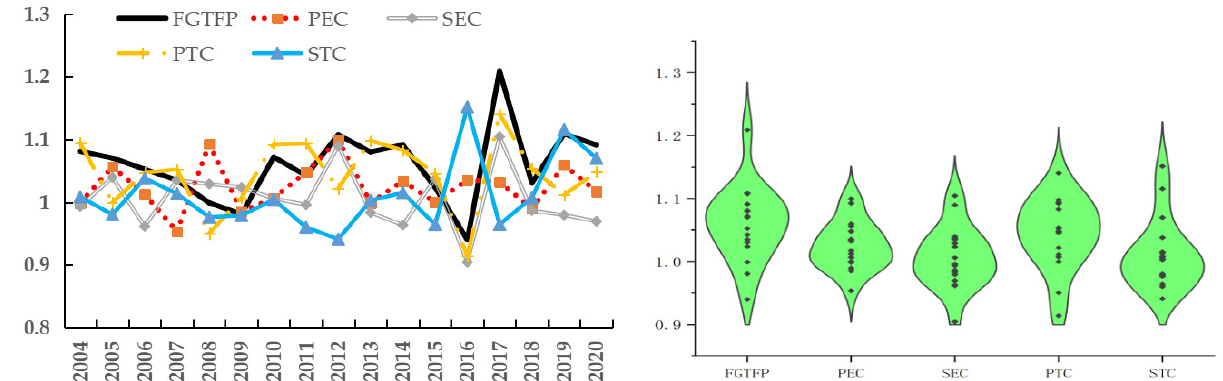
Figure 5. The Zofio index decomposition of freshwater aquaculture.